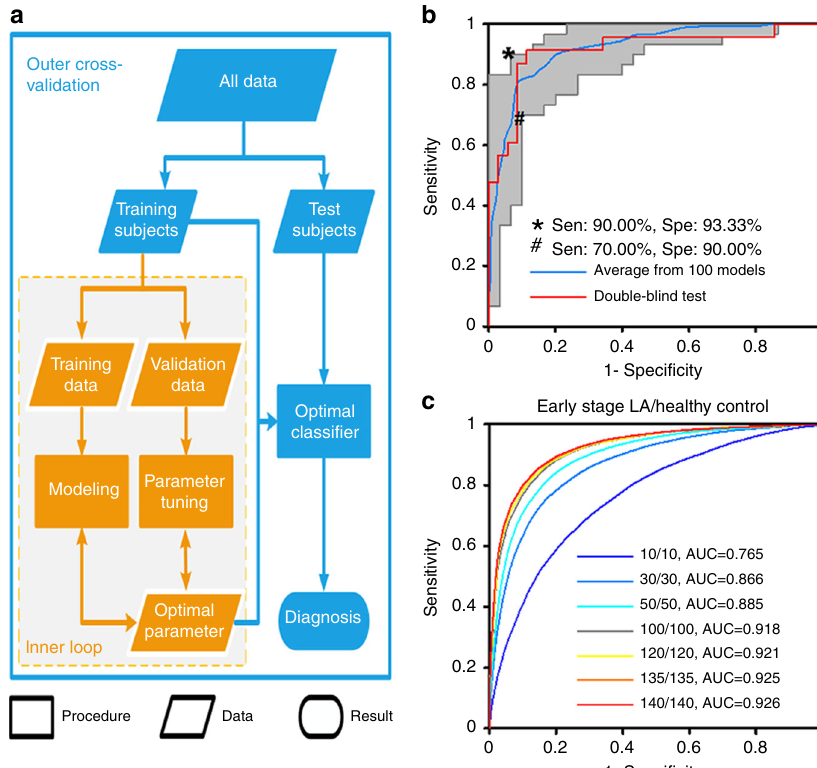
Fig. 3 Diagnosis of early-stage LA by machine learning. a Schematic work fl ow for the construction of classi fi cation models, including an inner loop (machine-learning stage, orange) to tune the hyperparameters for the optimal classi fi er and outer cross-validation (classi fi er building stage, blue) to evaluate the discriminant performance. b Receiver operating characteristic (ROC) curves for the classi fi er designed to distinguish between early-stage LA patients and healthy controls. The colours of ROC curves — blue represented the ROC curve obtained by averaging 20 rounds of fi ve-fold nested cross- validations (100 models in total) with a mean AUC of 0.921 (95% con fi dence interval (CI): 0.891 – 0.953), and the optimized number of training subjects was 240 (120/120, LA/control); red represented the ROC curve obtained from double-blind test (23/35, LA/control), showed AUC of 0.915 with diagnostic sensitivity of 88.57% and speci fi city of 91.30%; the grey area indicated the speci fi city/sensitivity of all independent ROC curves from 100 models, showing the diagnostic performance of the best (asterisk) and worst (hash mark) classi fi ers. c Averaged ROC curves with AUC to optimize the number of training subjects, analyzing from 20 (10/10, LA/control) to 280 (140/140, LA/control). Source data are provided as a Source Data fi